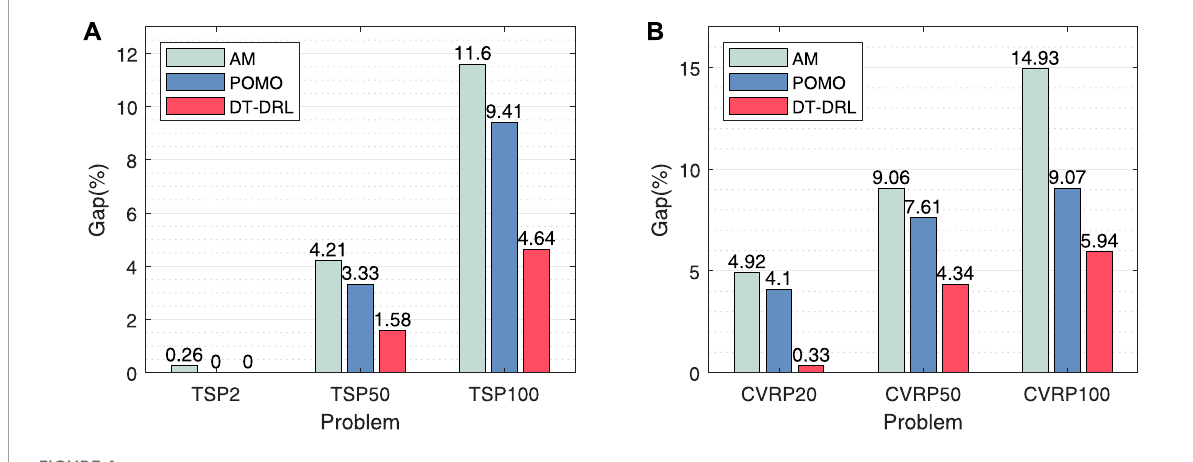
FIGURE 4 Generalization results between AM, POMO, and our DT-DRL on (A) TSPs and (B)